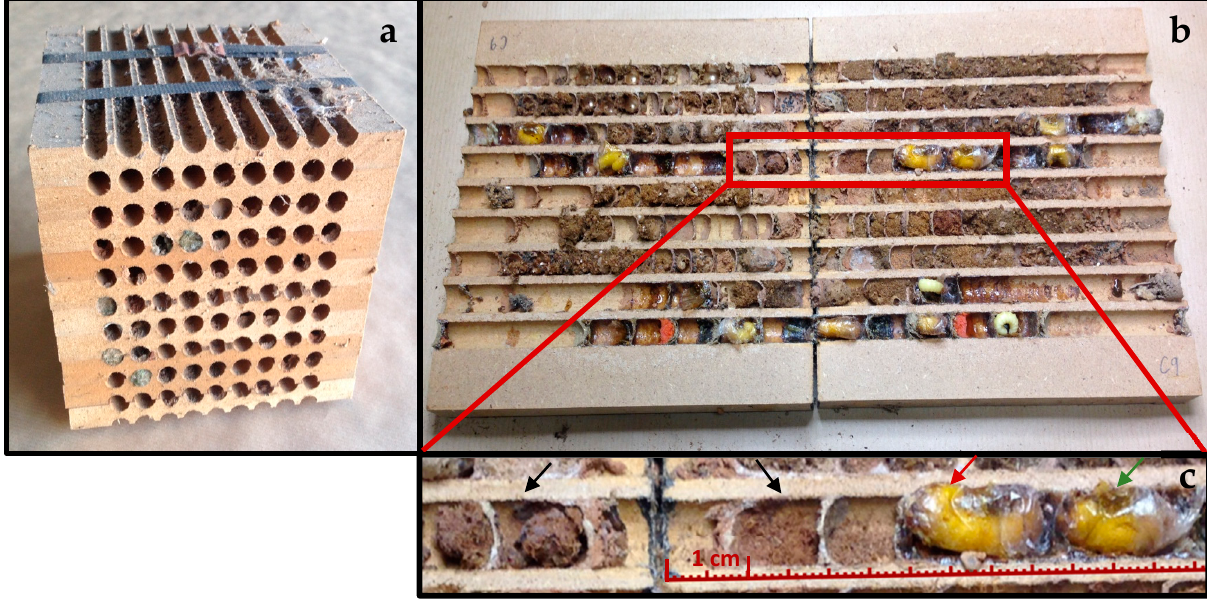
Figure 1. ( a ) Trap nests made of grooved boards stacked together in a solid block. ( b ) Opened individual grooved board showing the upper part (left) and lower part (right) of the same tunnels. ( c ) Detail of cohabitated tunnel with parasitized Osmia cocoons in the inner cells (black arrows), M. sculpturalis female prepupa situated next to O. cornuta cells (red arrow) and M. sculpturalis male prepupa (green arrow).